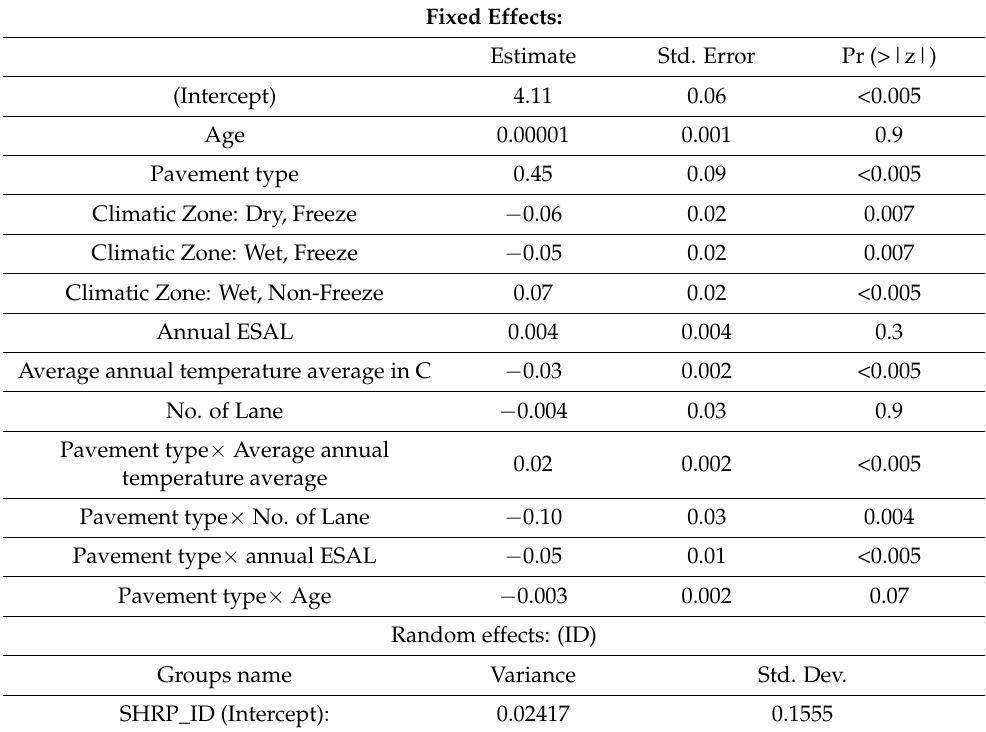
Table 2. Results of identified factors on pavement friction